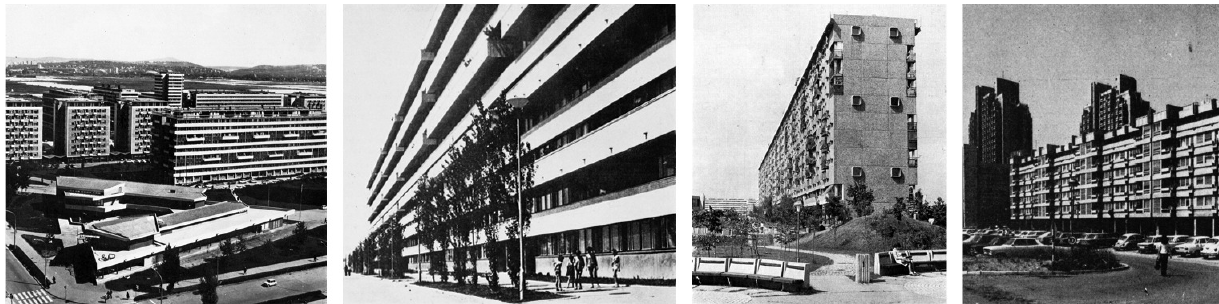
Figure 4. New Belgrade blocks (from left to right): (a) Residential buildings and local community centre in Block 1 (1963), (b) residential building in Block 21 (1965), (c) residential building in Block 28 (1974), and (d) residential buildings in Block 23 (1974). Source: Stojanovic and Martinovic (1978, pp. 150 [c], 209 [a], 230 [b,